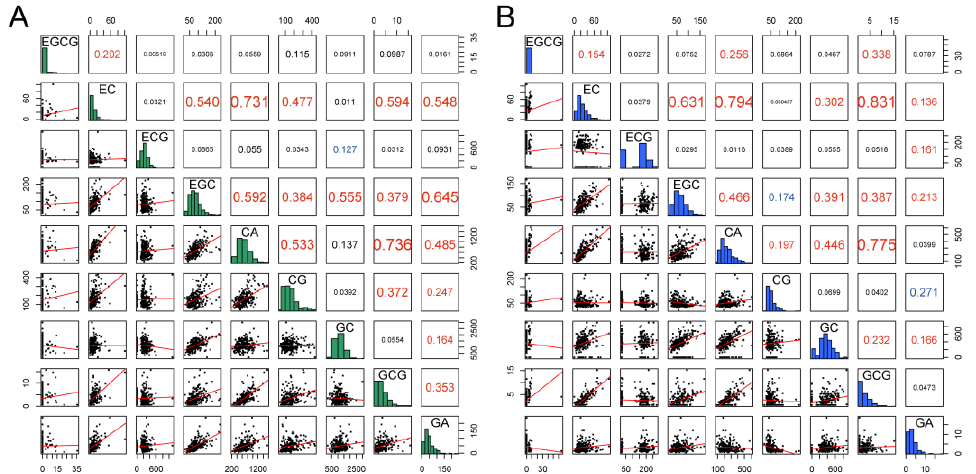
Figure 2. Pearson correlation analysis of catechin compositions in the leaves of persimmon germplasm leaves (( A ) young leaves; ( B ) adult leaves). The bottom half of the diagram is a scatter diagram and a fitting curve (red line). The correlation coefficient in the upper corner is blue, which means a very significant negative correlation; red, means a very significant positive correlation; the larger the font, the more significant the correlation. The diagonals show histograms and probability density